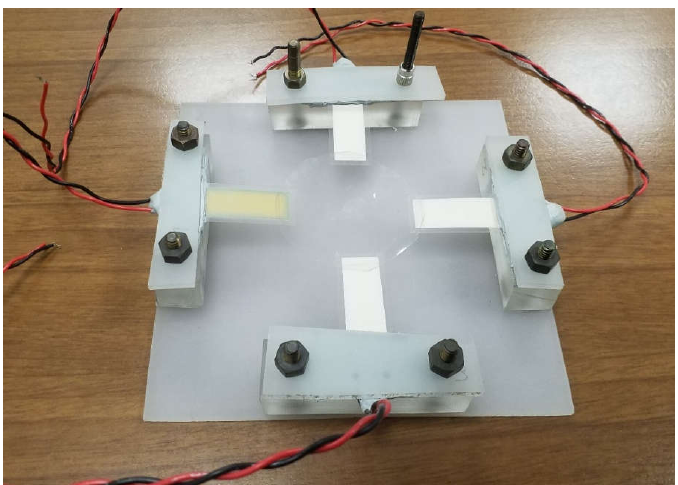
Figure 5. Piezoelectric structures: two bridges 6 cm and 15 cm long.